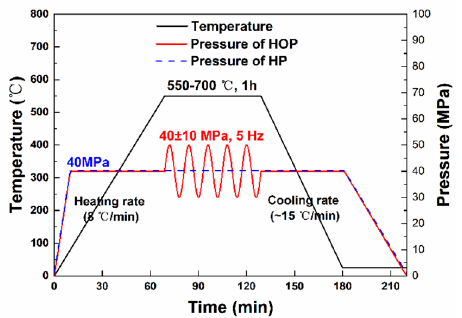
Figure 1. Detailed sintering schedule of HOP and HP.